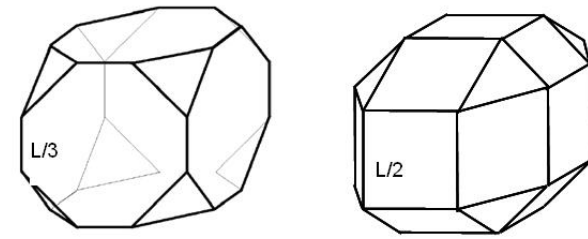
Fig. 20. Different testing methods for rockfall protection systems: free trajectory (left) with impact including rotation but imprecise impact location; cable car guided oblique (middle) and vertical (right) impact with precise impact location.